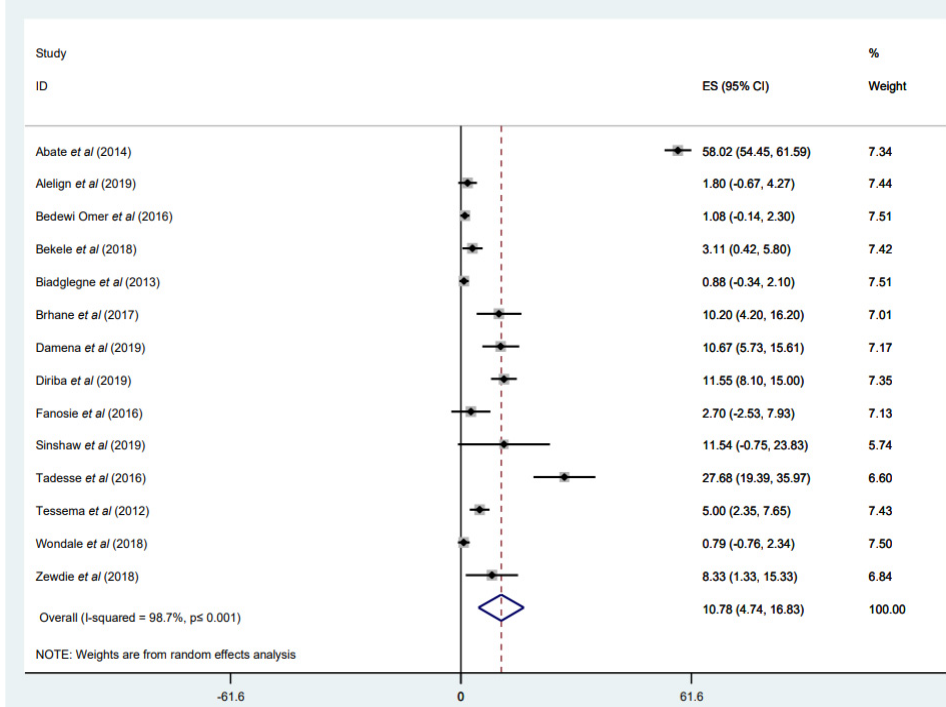
Figure 9. Forest plot showing the weighted pooled prevalence of multidrug-resistant tuberculosis (MDR-TB) among overall TB cases.